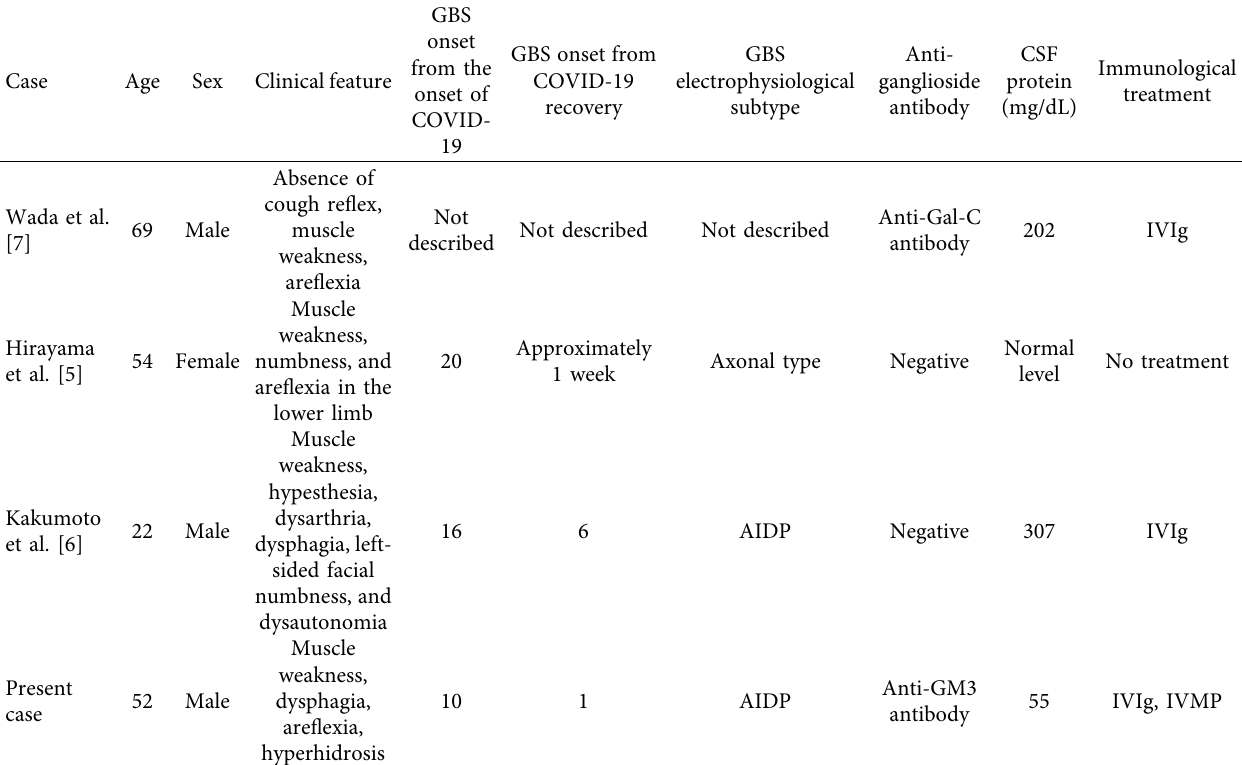
Table 2: Demographics of previous and present cases of Guillain-Barr´e syndrome associated with COVID-19 in Japan.